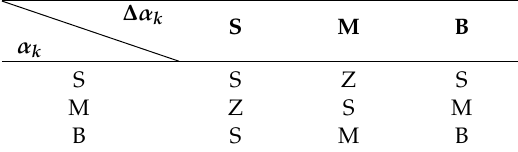
Table 1. Fuzzy rules for forgetting factor of the proposed adaptive fuzzy fading Kalman filter.